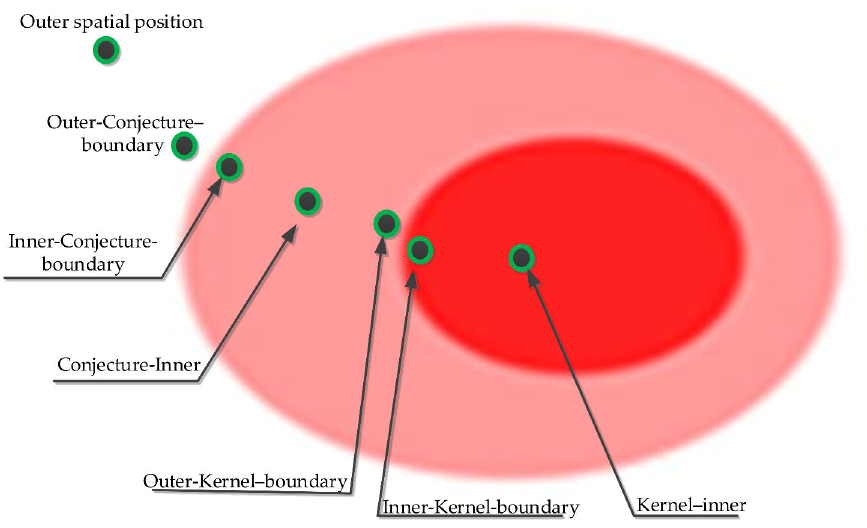
Figure 4. The seven possible relative spatial positions of sensor nodes towards the geometry of a monitored